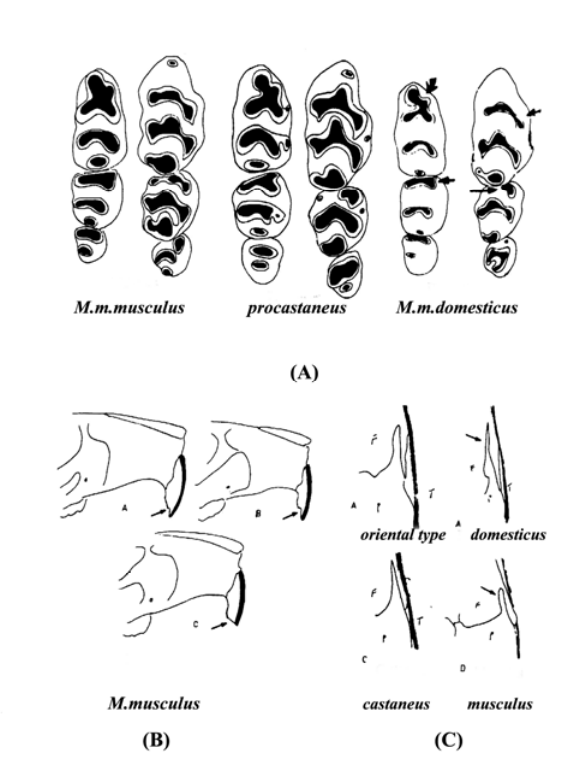
F IG .7- Comparison of character states in three subspecies and procastaneus samples of